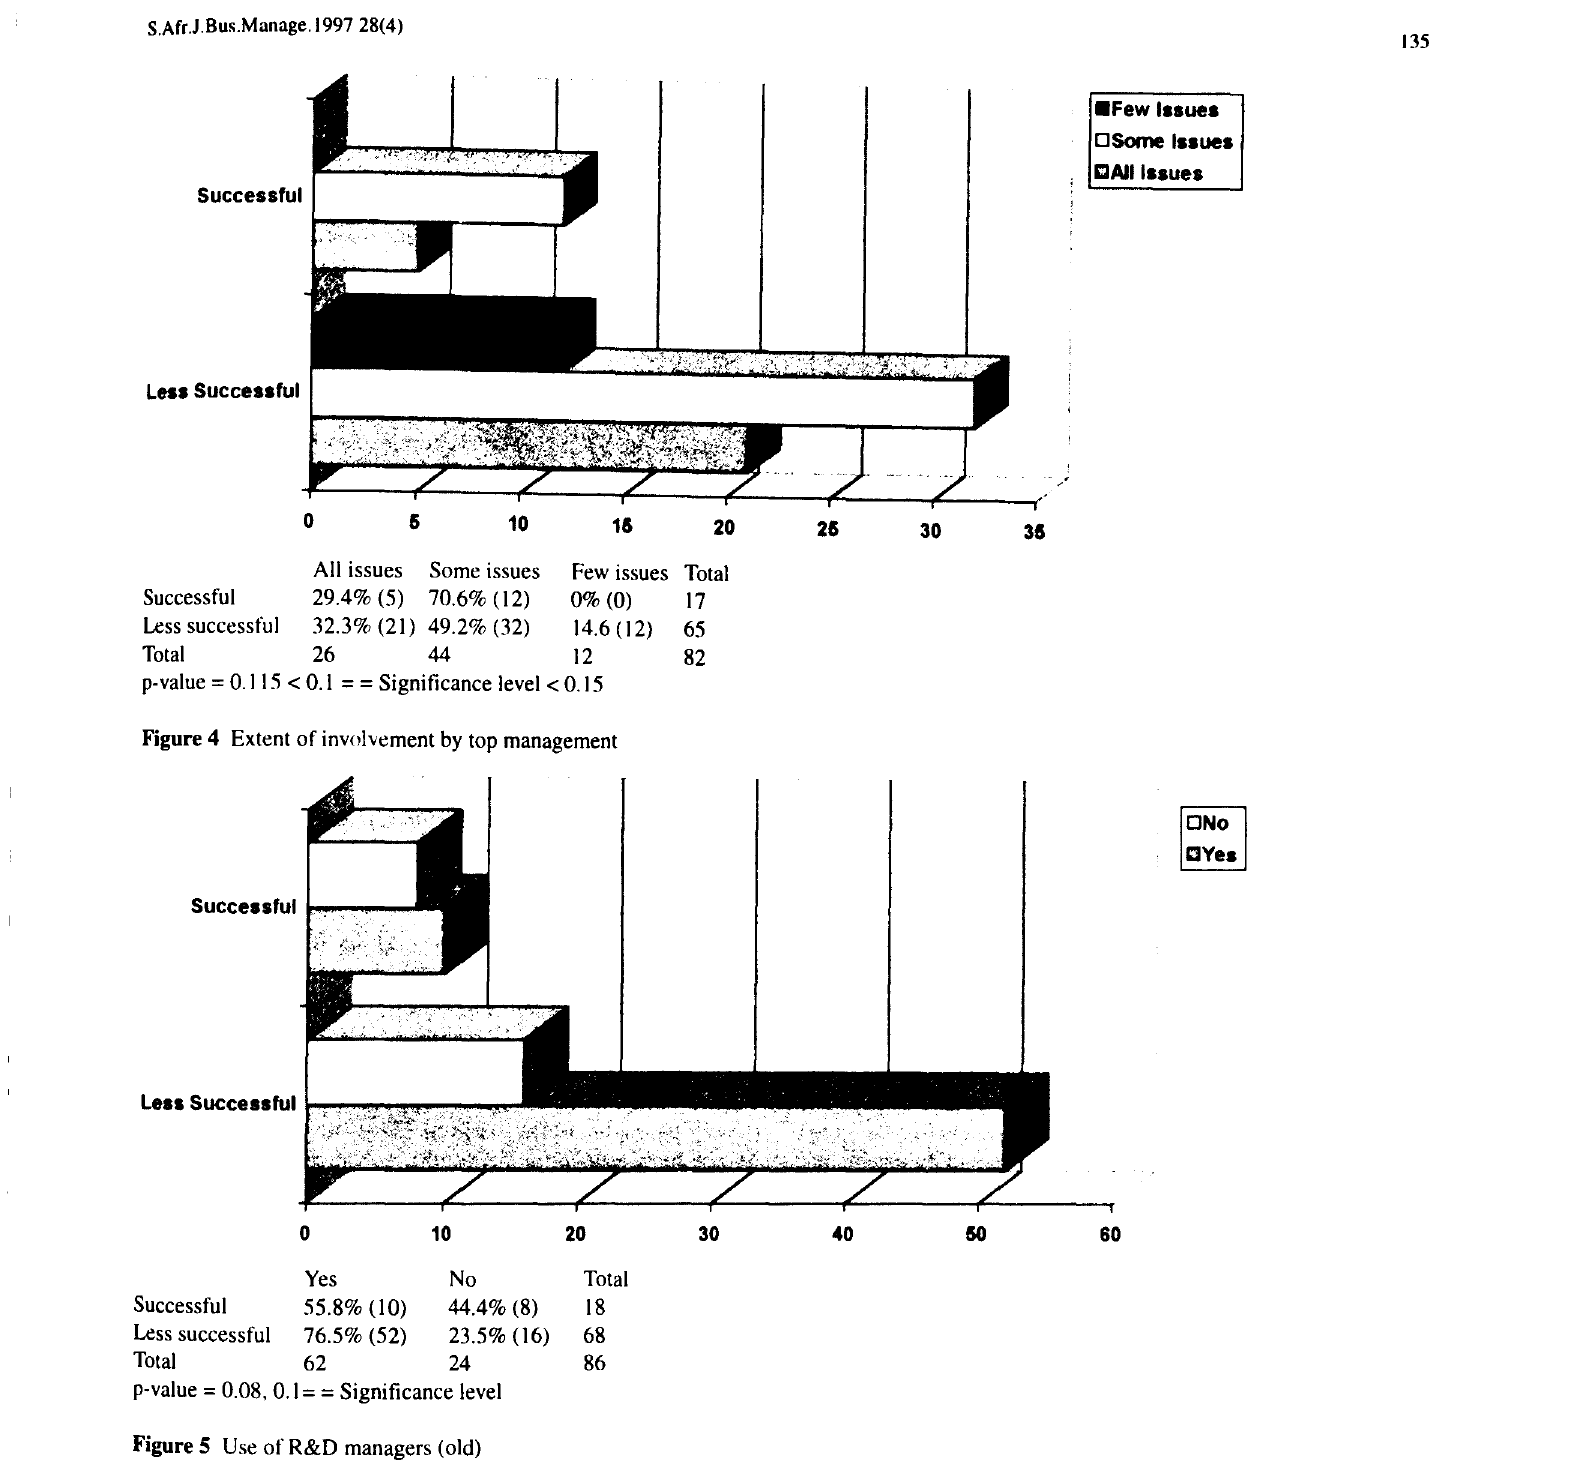
Figure 5 Use of R&D managers